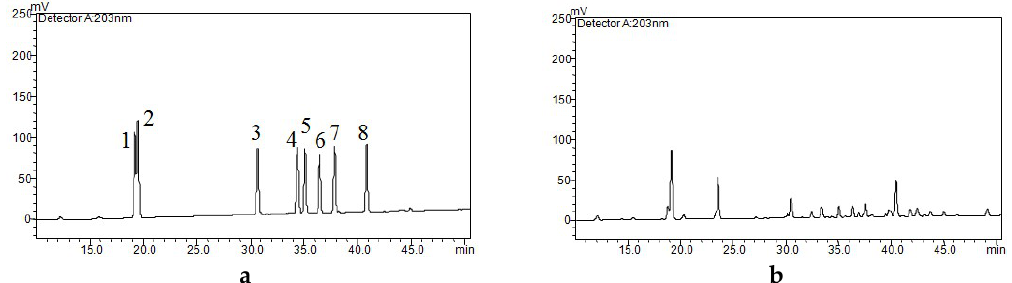
Figure 5. HPLC profiles of ( a ) the standard mixture solution and ( b ) a sample prepared using IL-UAE from ginseng flower buds. Peaks 1–8 correspond to ginsenoside Rg 1 , Re, Rf, Rg 2 , Rb 1 , Rc, Rb 2 , and Rd, respectively.